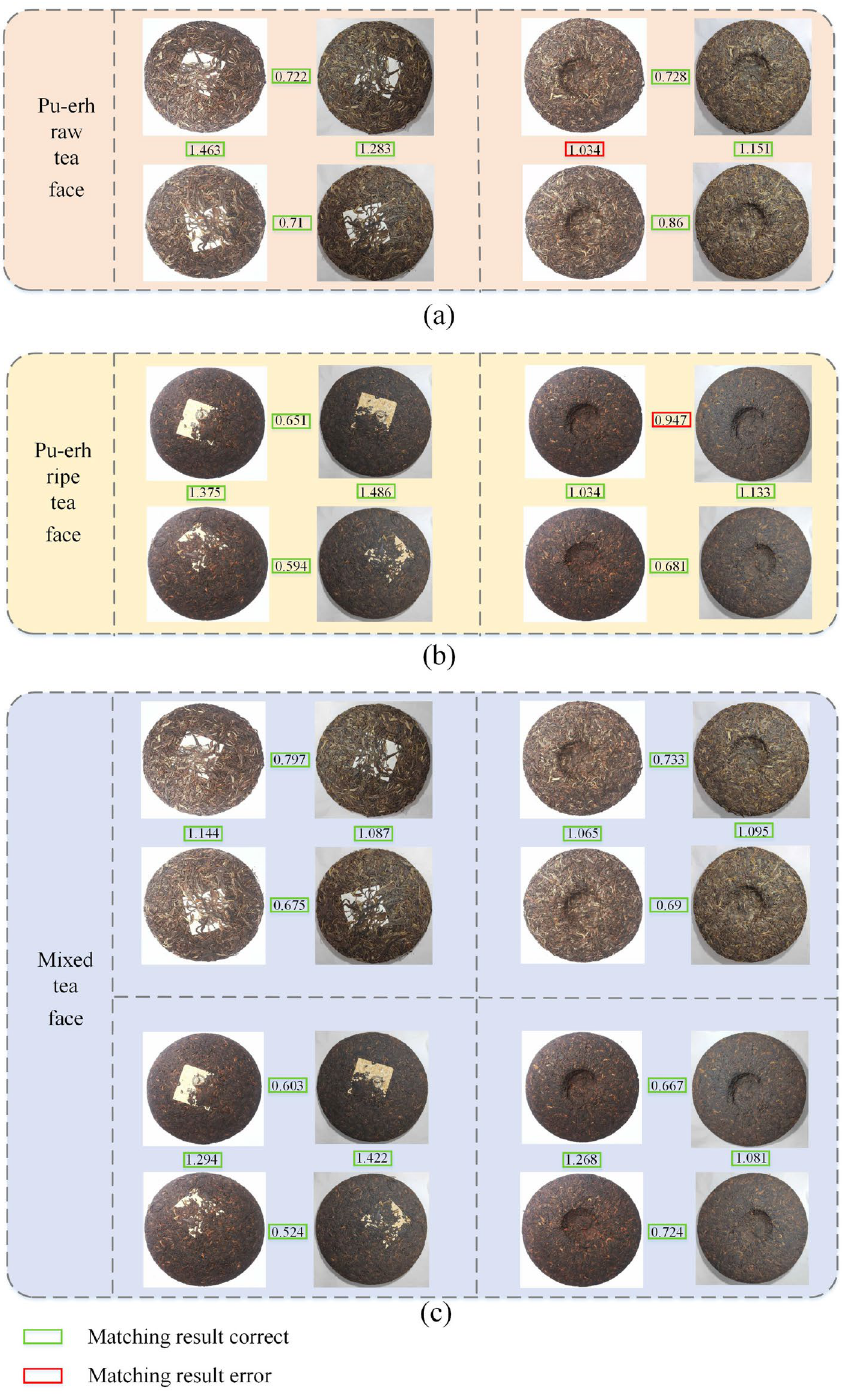
Figure 14. Validation case of TeaFaceNet